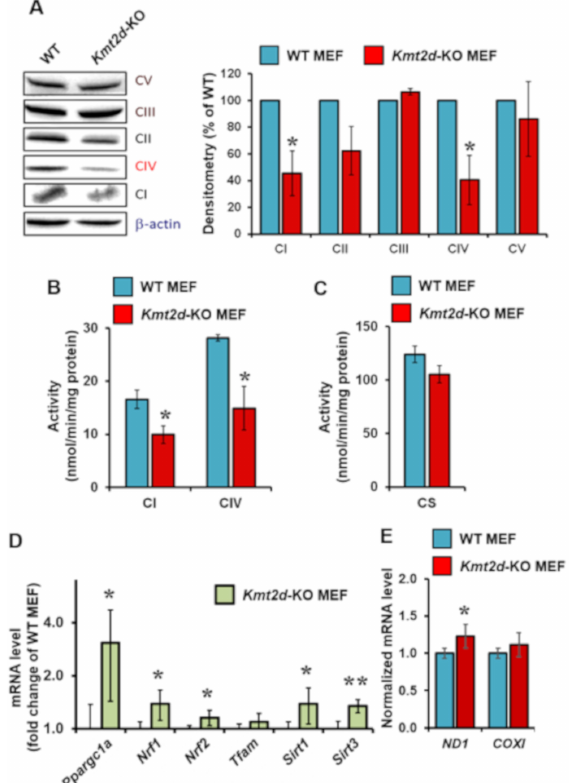
Figure 4. Molecular and functional analysis of the mitochondrial respiratory chain in WT and Kmt2d -KO MEF. ( A ) Immunoblotting of OxPhos complexes; a representative Western blotting is shown (on the left) with normalized densitometric and statistical analysis (means ± SEM of n = 4); *, P < 0.05 vs. Kmt2d -KO MEF. ( B ) Enzymatic activity of complex I (CI) and complex IV (CIV); ( C ) enzymatic activity of citrate synthase; in ( B , C ), the activities were carried out by spectrophotometry assay on cell lysate. ( D ) RT-qPCR analysis of the expression of genes coding for the indicated proteins involved in the mitochondrial biogenesis; the values are fold changes of the transcript in Kmt2d -MEF with respect to WT MEF (means ± SD of n = 3; *, P < 0.05; **, P < 0.01). ( E ) RT-qPCR analysis of the expression of mtDNA-coded genes for a subunit of complex I (ND1) and of complex IV (COXI); the values are normalized with respect to WT MEF (means ± SD of n = 3; *, P <